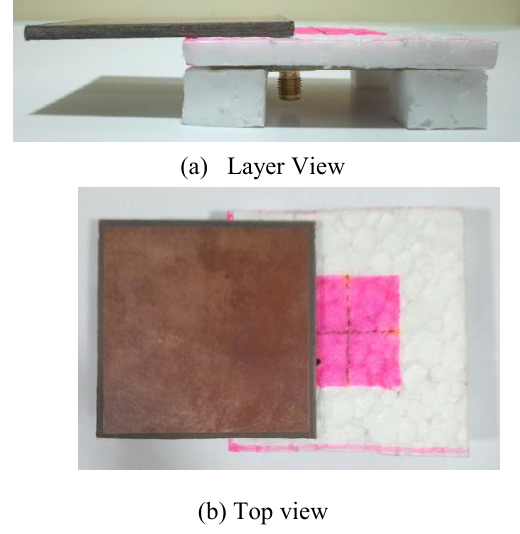
Figure 8. Fabricated prototype of steerable